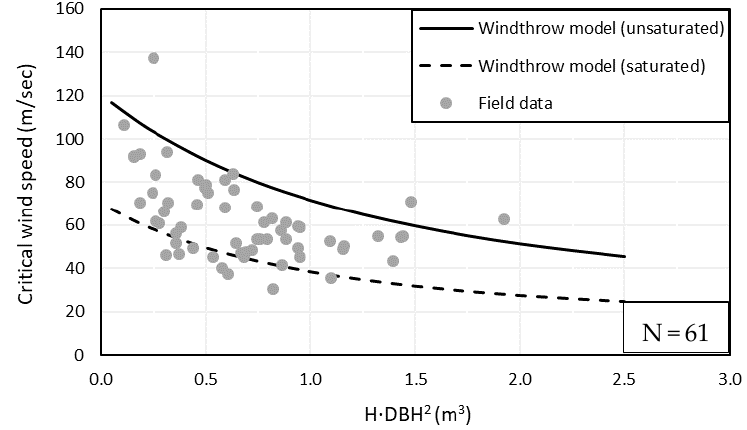
Figure 6. Relationship between critical wind speed and uprooted tree volume.